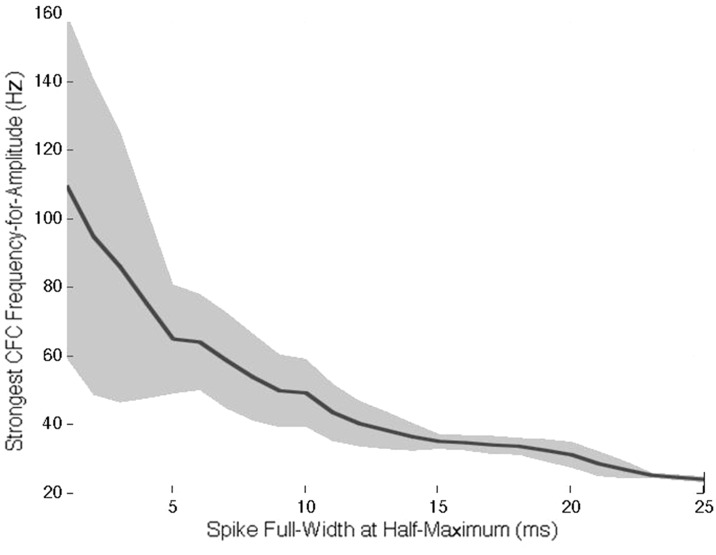
Preferred frequency-for-amplitude as a function of Gaussian spike width.Shaded area reflects one standard deviation of the preferred frequency across 100 iterations (see Materials and Methods).